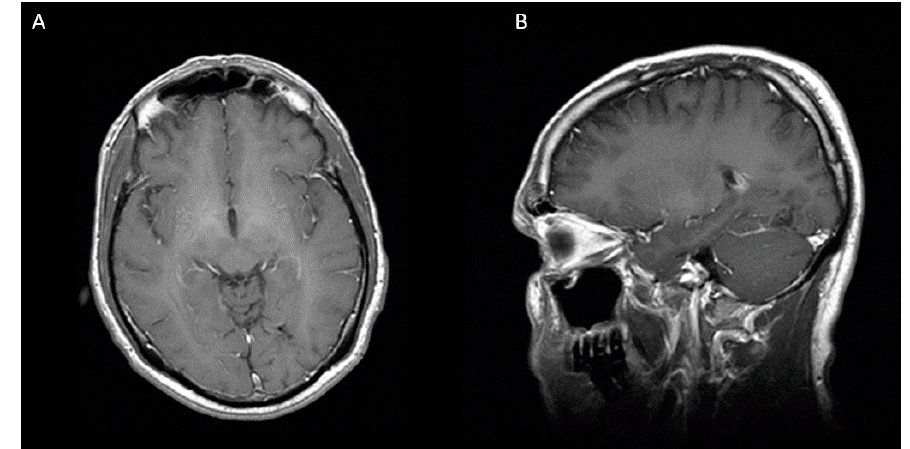
Figure 3. Eight months after second stereotactic needle aspiration, MRI is showing a complete resolution of cerebral abscess. ( A ) Axial view ( B ) Sagittal view. resolution of cerebral abscess. ( A ) Axial view ( B ) Sagittal